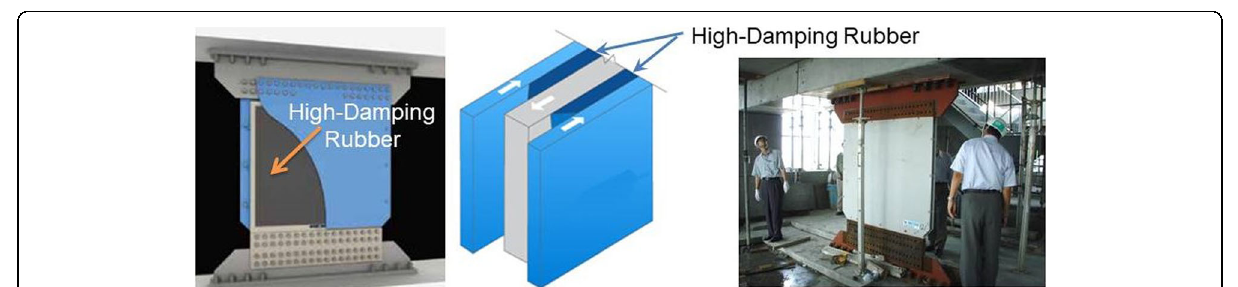
Fig. 17 Viscoelastic damper using high-damping